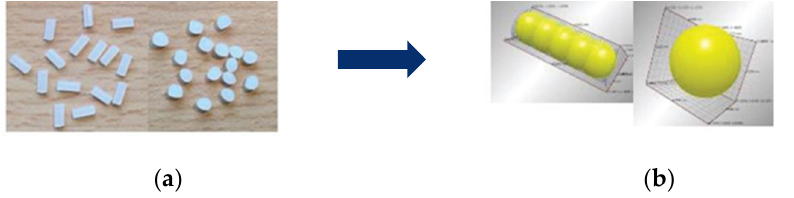
Figure 6. Transfer of the ( a ) real granule shape into ( b ) 3D simulation adapted with permission from [24 ] . 2021 Trippe.